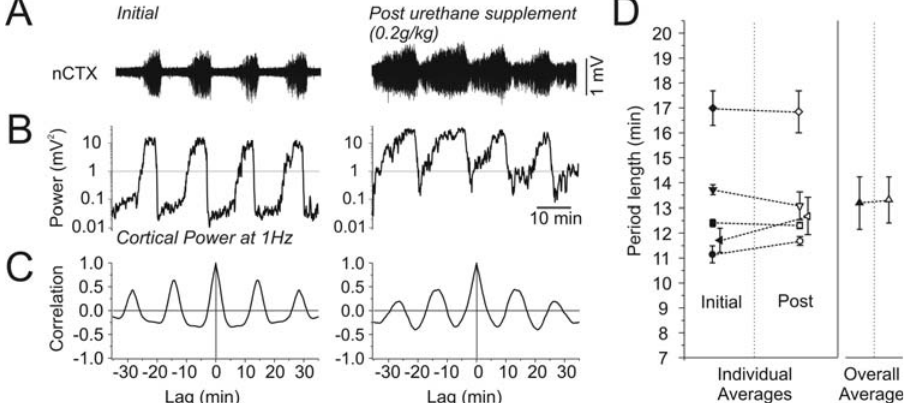
Figure 2. The rhythmicity and periodicity of state alternations under urethane were not affected by moderate increases in anaesthetic dosage. A) Long duration raw cortical EEG traces demonstrating the electrographic effects of a moderate increase in the depth of urethane anaesthesia. Although the overall amplitude of the signal increased following the supplemental dose, state alternations (apparent as rhythmic changes in signal amplitude) were still observed. B) Spectrographic power at 1 Hz for the traces shown in A. Following the supplemental dose, power continued to fluctuate at a similar periodicity although there was an increase in the overall power in addition to the time spent in the deactivated state (and consequently a decrease in the time spent in the activated state). C) Autocorrelation of power values in B demonstrating similar rhythmicity before and after supplemental urethane administration. D) Individual (paired for animal across conditions by symbol and line) and overall averages demonstrating the consistency of alternation period duration before and after the supplemental doses of urethane across all experiments. Neither the individual nor the overall averages were significantly different.